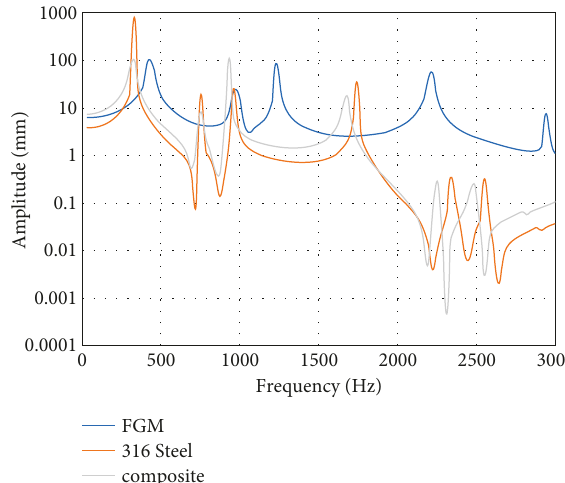
Figure 23: Frequency response diagram of the 316 steel, composite, and FGM crankshaft.